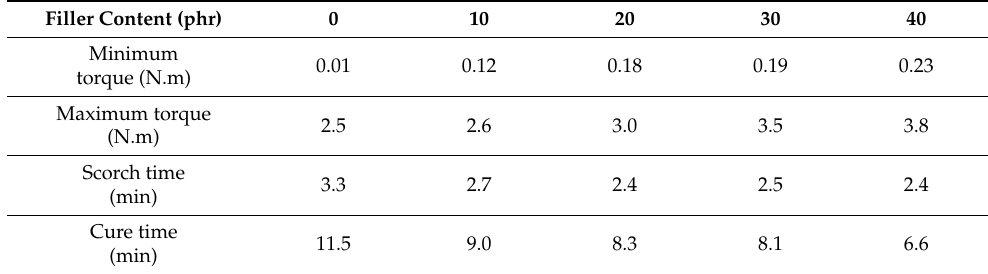
Table 2. Curing characteristics of NR composites filled with coconut shell powders